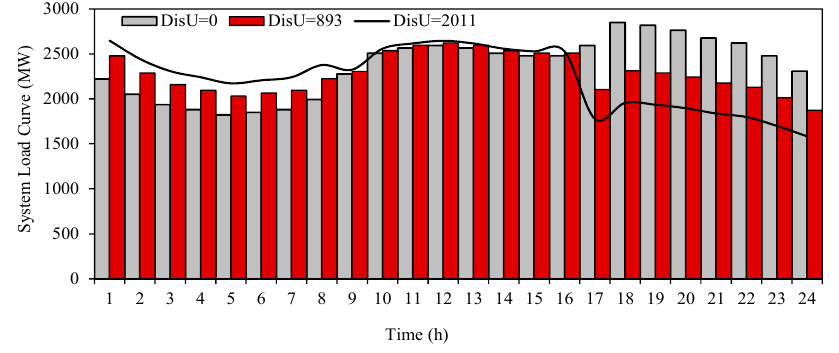
Figure 5. The aggregated load profile of the system.